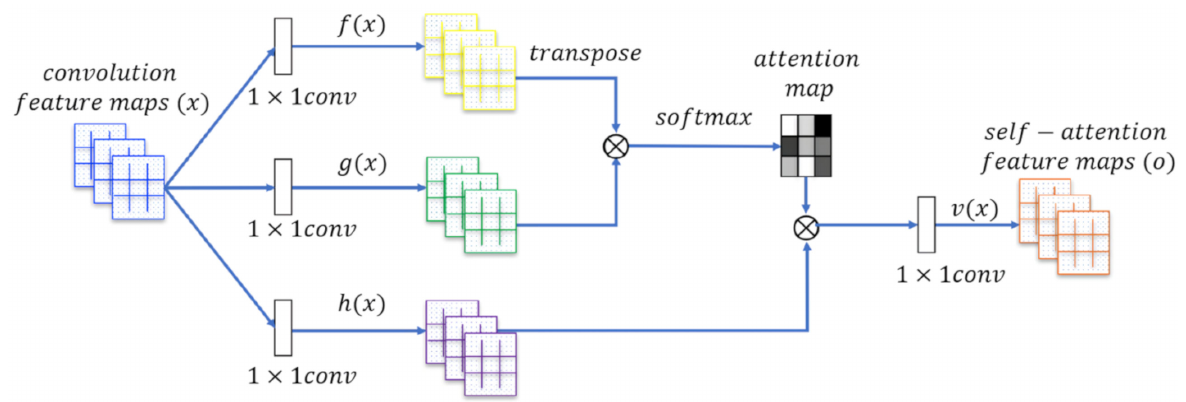
Figure 3. Self-attention algorithm of SAGAN (Self-Attention Generative Adversarial Networks)